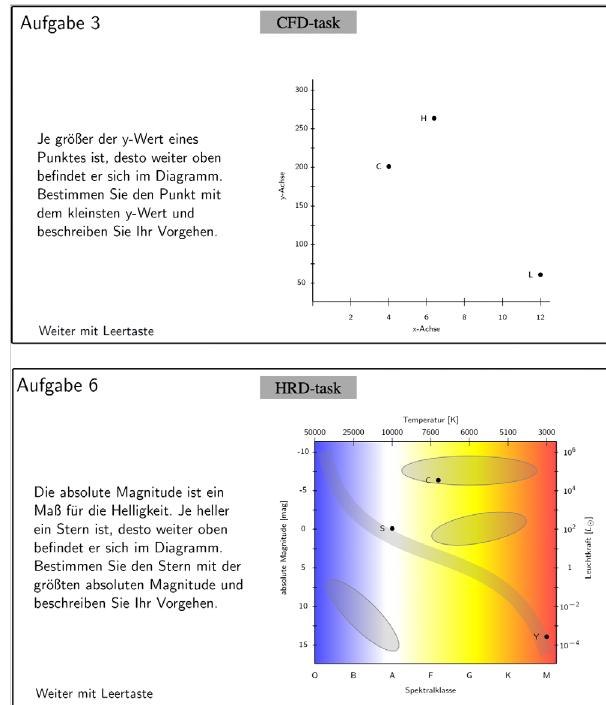
FIG. 2. Isomorphic pair of items as originally used in the study (English translations can be found in the Supplemental Material [51]). The top item shows three points in an x - y coordinate system (C,H,L), and students must compare the y values to find the point with the largest y value. The bottom item shows three stars (S,C,Y), and students must select the star with the largest absolute magnitude. Note the parallel item design, especially the congruent position of the points or stars in the diagrams.